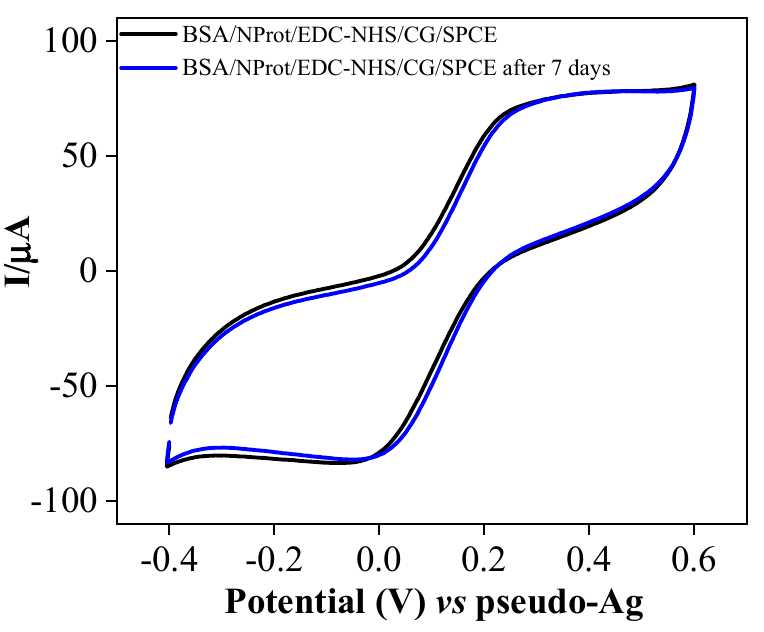
Figure 3. Stability of the immunosensor through cyclic voltammetry in 5 mmol L − 1 [Fe(CN)6] 3 − /4 − + 0.1 mol L − 1 KCl.